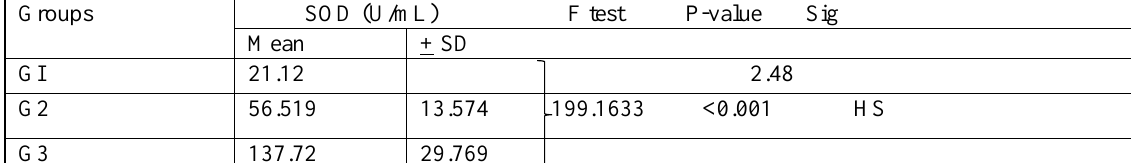
Table 3: describe mean, standard deviation of SOD Levels (U/mL) of the three groups